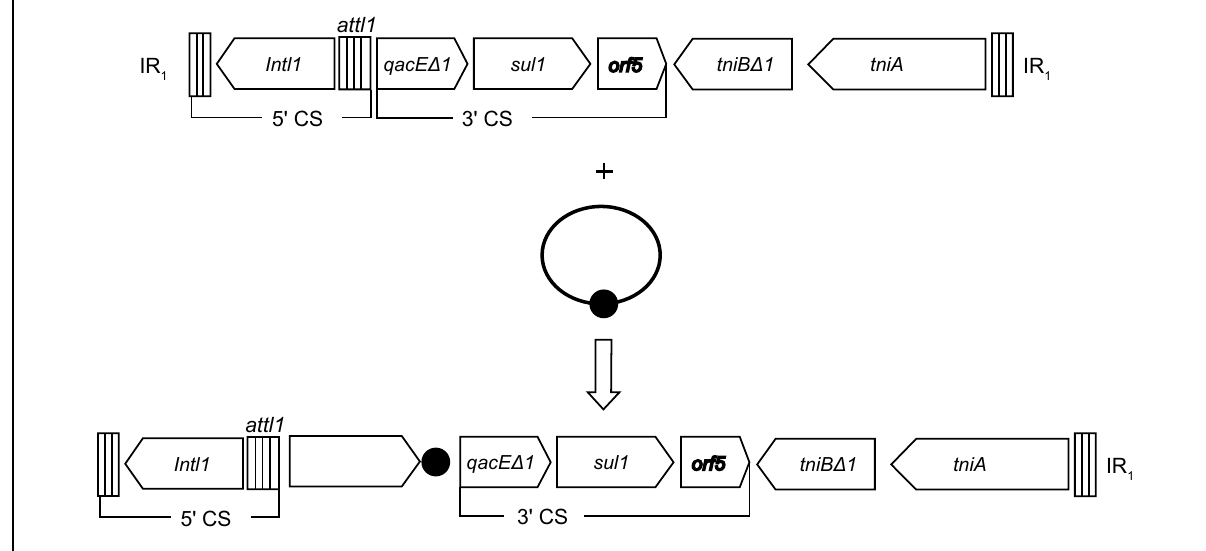
Figura 2 – Representação esquemática da inserção de cassete gênico na primeira posição em integron de classe 1. IR representam terminais de repetição invertidos. A região conservada 5’ do integron consiste em intI1 e sítio de inserção attI1. O círculo de preenchimento preto representa 59-be do respectivo cassete gênico. A seta dos respectivos genes indica a direção da transcrição. A região conservada 3’ consiste nos genes qacE Δ 1, sul1 e orf5 de função desconhecida, seguidos do módulo